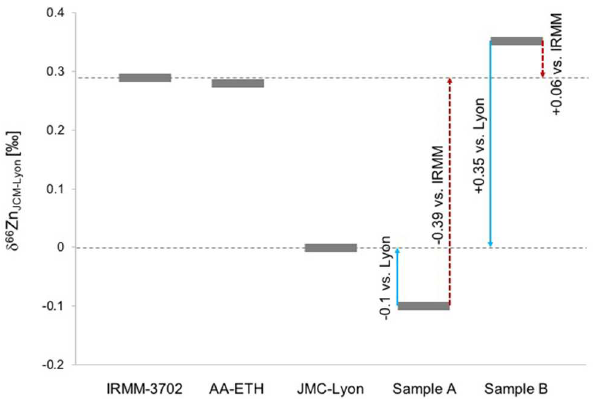
FIGURE 1 | Relative location of δ 66 Zn JMC − Lyon values of different international standards (IRMM-3702, AA-ETH, SRM-683) and the effect of conversion for generic samples A and B against IRMM-3702 or JMC-Lyon standards,